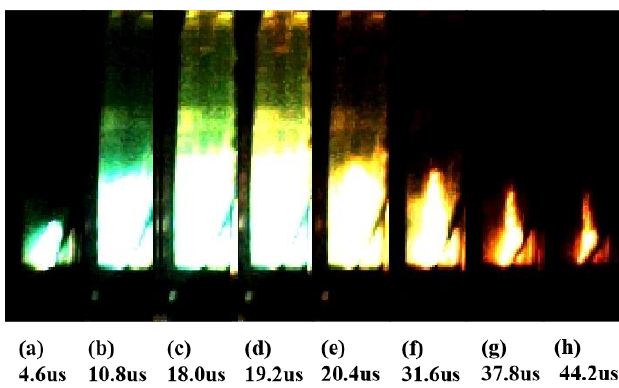
Figure 13. The development process of the arc channel.